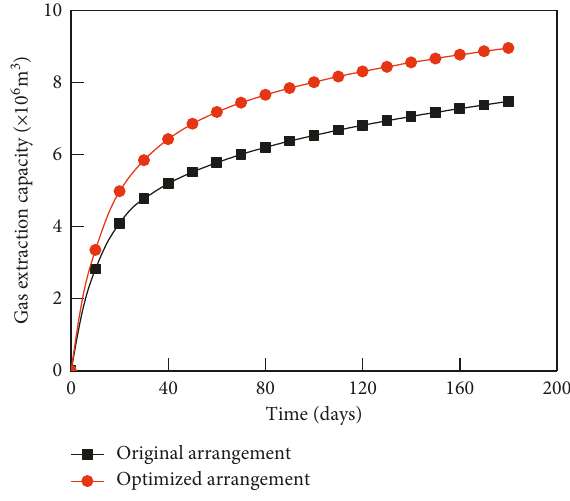
Figure 9: Different drilling arrangement schemes for gas extraction.